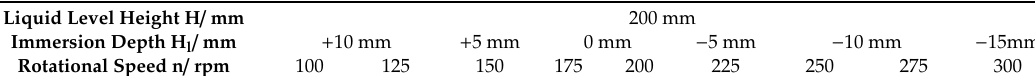
Table 3. Experimental Scheme.